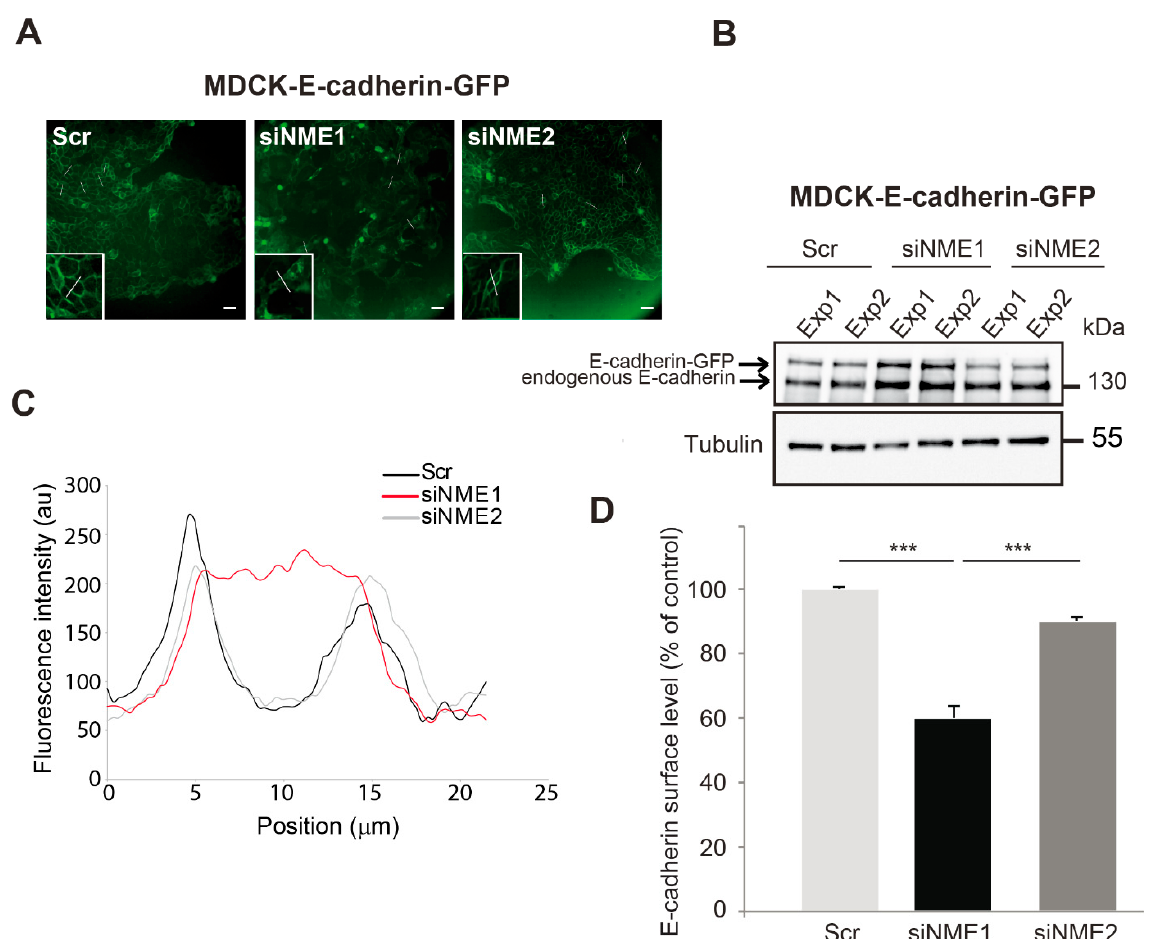
Figure 3. E-cadherin distribution is altered in NME1 -depleted epithelial cells. ( A ) GFP fluorescence of control (Scr) MDCK epithelial cells stably overexpressing E-cadherin-GFP (MDCK E-cadherin-GFP) and the same cells treated with siRNAs to silence NME1 (siNME1) or NME2 (siNME2) 72h post-transfection. White lines indicate typical regions used for the line scan profiling shown in ( C ). Scale bar, 25 µm. ( B ) Lysates of cells as in ( A ) were analyzed by Western blotting with an antibody against E-cadherin. The results of two independent experiments (Exp1 and Exp2) are shown. Equal loading was verified by Western blotting for tubulin. Molecular weights are indicated in kDa. ( C ) Line scan profiling of the control, siNME1, and siNME2 MDCK cell populations. ( D ) Cells as in ( A ) were analyzed by FACS for cell surface E-cadherin levels and quantified. Three independent experiments were performed. Data are expressed as means ± SEM. *** p < 0.001.